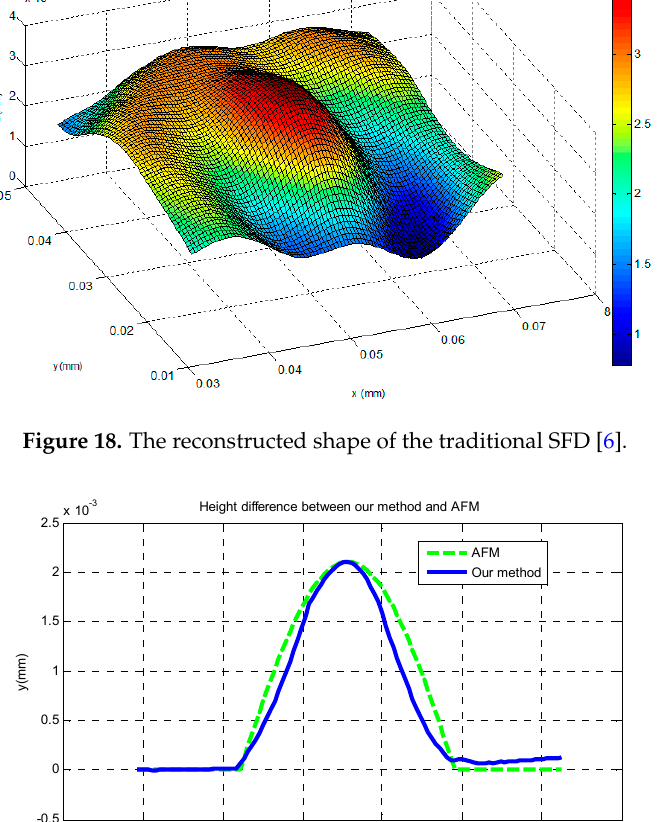
Figure 18. The reconstructed shape of the traditional SFD [6].